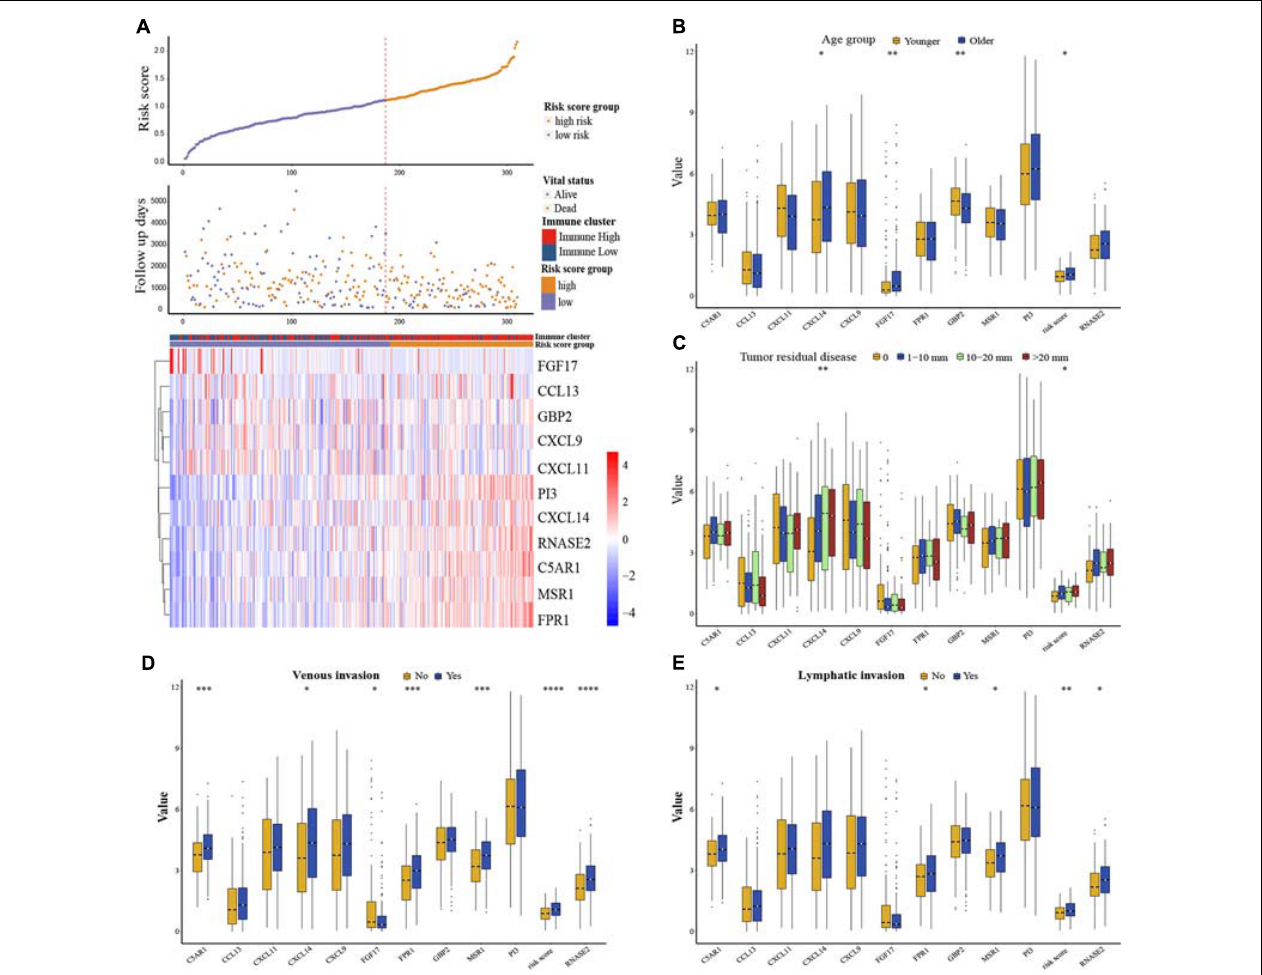
FIGURE 7 | Risk score distribution and clinical stratification for the whole TCGA cohort. (A) The distribution of risk scores, survival status, and expression pattern of immune genes in the whole TCGA dataset. (B) OV patients were divided into two groups according to median age, and then the relationships among risk score distribution and expression levels of immune genes between age groups were explored. (C) Relationships among risk score distribution, expression levels of immune genes, and different status of tumor residual disease. (D) Relationships among risk score distribution, expression levels of immune genes, and different status of venous invasion. (E) Relationships among risk score distribution, expression levels of immune genes, and different status of lymphatic invasion. ∗ p < 0.05, ∗∗ p < 0.01, ∗∗∗ p < 0.001, ∗∗∗∗ p <